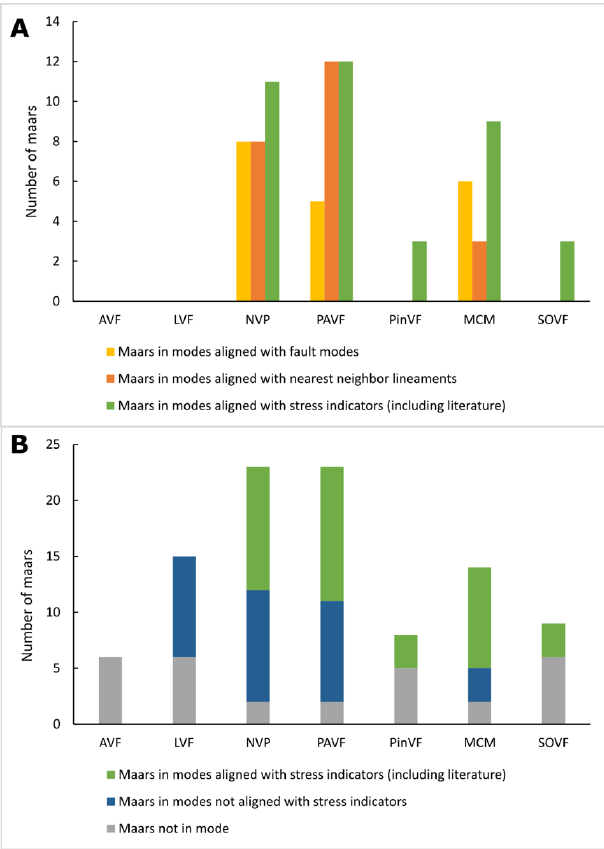
Figure 11: Comparison of modes and alignment across the seven volcanic fields. [A] Number of maars in modes aligned with different stress indicators. [B] Number of maars in and out of modes aligned with stress indica-